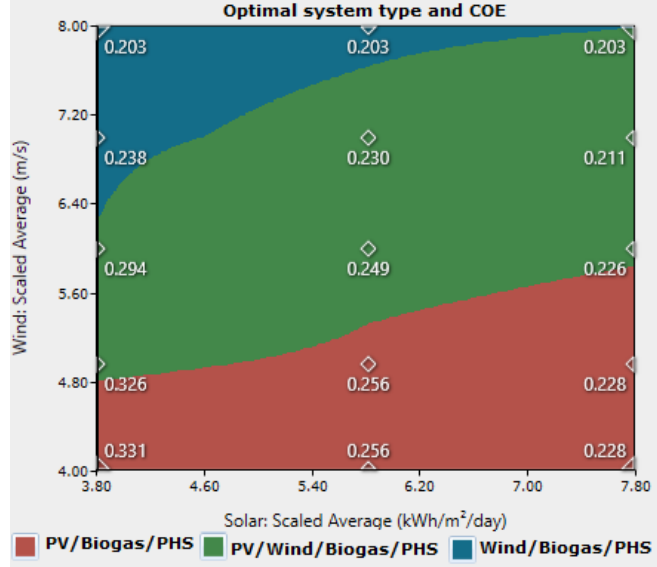
Figure 18. Result of sensitivity analysis of wind speed and solar radiation.